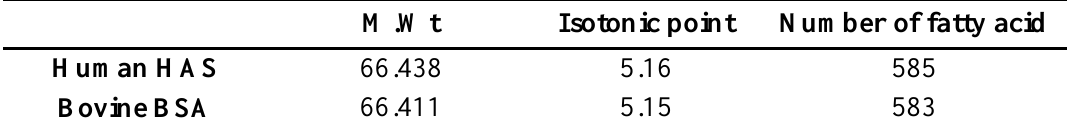
Table 2. Comparison in Structure Amid HSA as well as